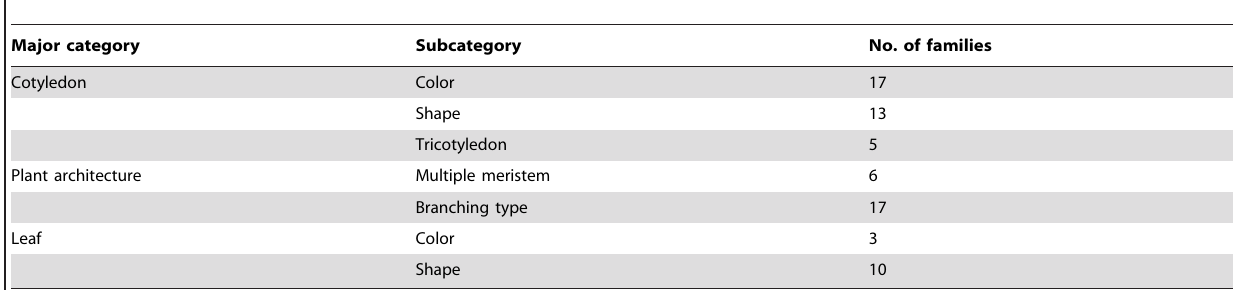
Table 2. Classes of observed mutant